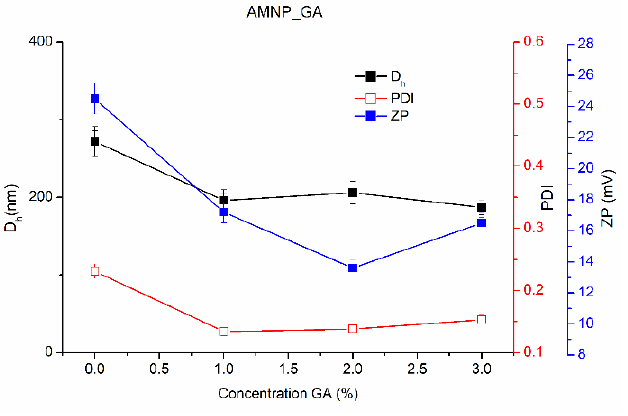
Figure 2. Variation of D h , PDI and ZP with the GA concentration used to functionalize the MNPs.